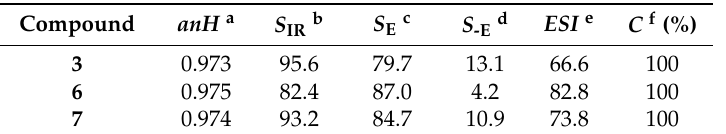
Table 3. Confidence level data for the IR and VCD spectra of 3 , 6 , and 7